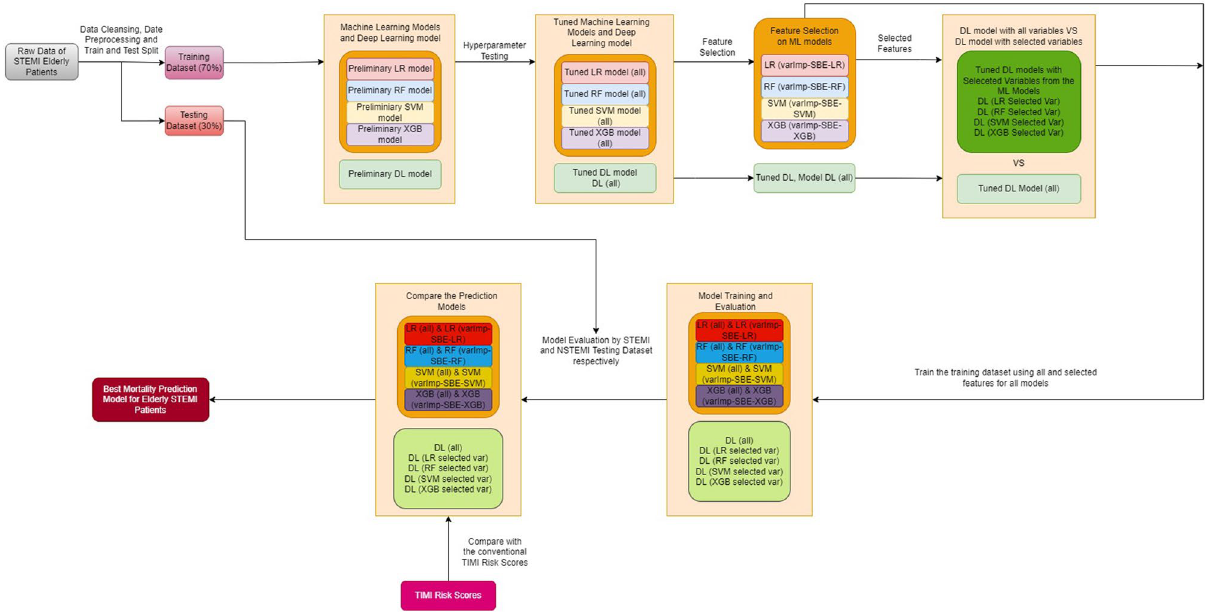
Figure 1. Research workflow and methodology applied in this